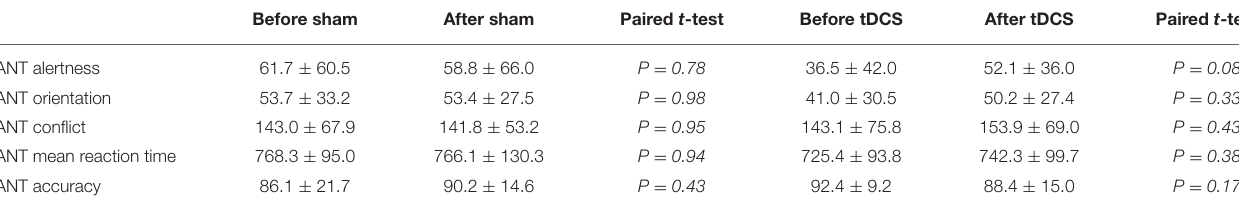
TABLE 3 | ANT results (Mean ± SD) before and after sham and active tDCS. Before sham After sham Paired t -test Before tDCS After tDCS Paired t -test